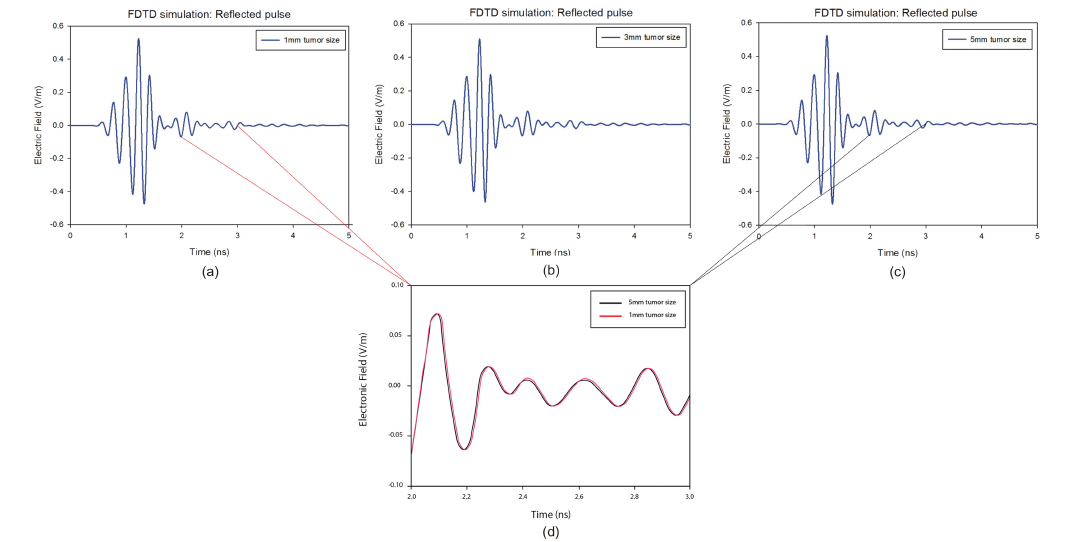
Figure 7. Backscattered responses with different tumor size at a predefined position of the breast model: ( a ) 1 mm, ( b ) 3 mm, ( c ) 5 mm. ( d ) represents a comparison between the responses with